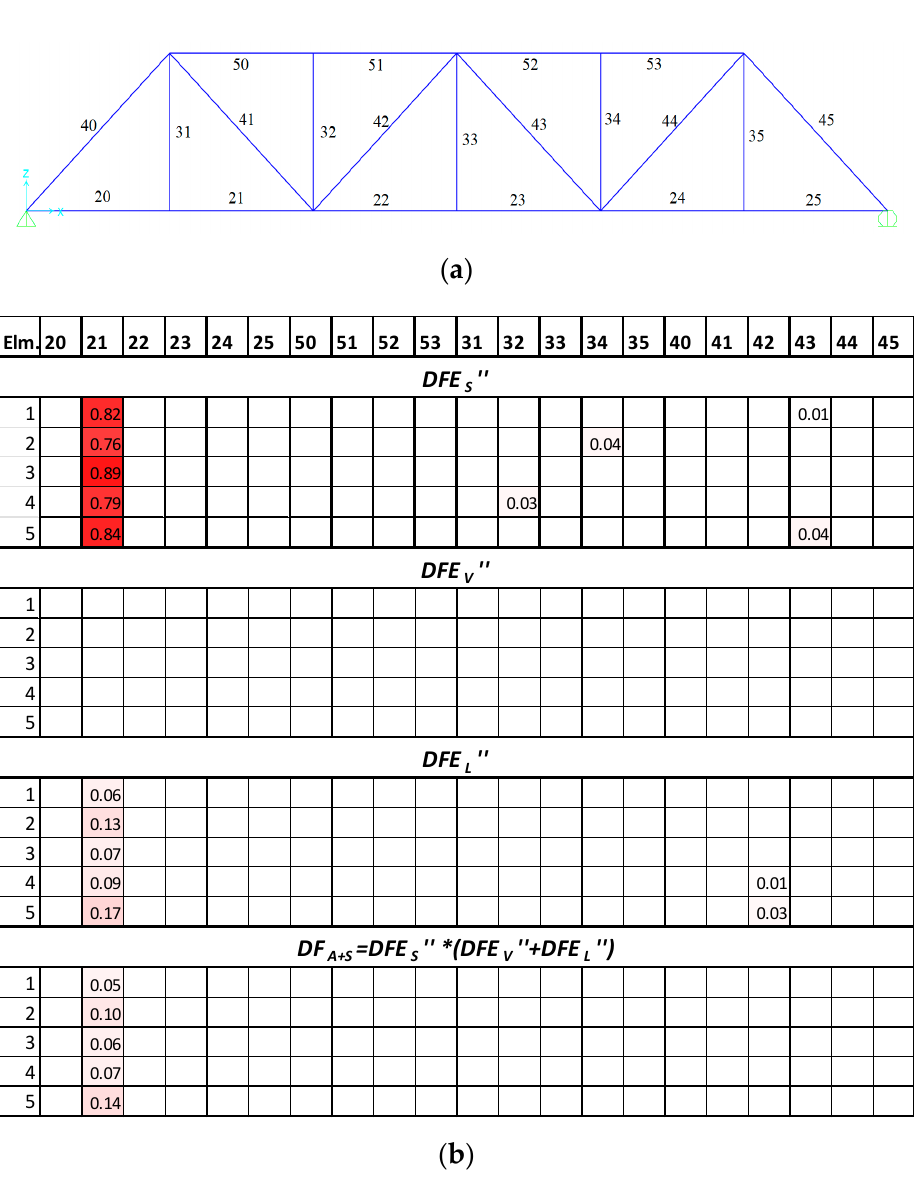
Figure 10. ( a ) Actual location of damage for damage case-2, ( b ) Identified damage using the proposed framework for damage case-2.